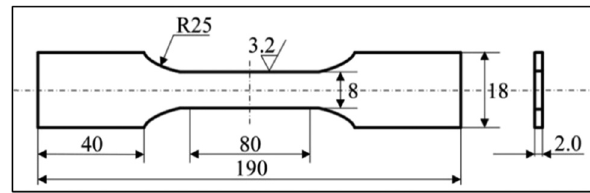
Figure 6: Schematic representation of the tensile sample ( all dimensions are in mm )